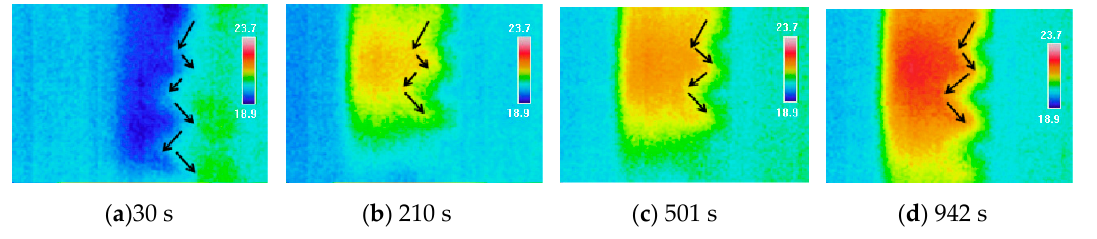
Figure 6. Thermal images of specimen A3 at different moments.